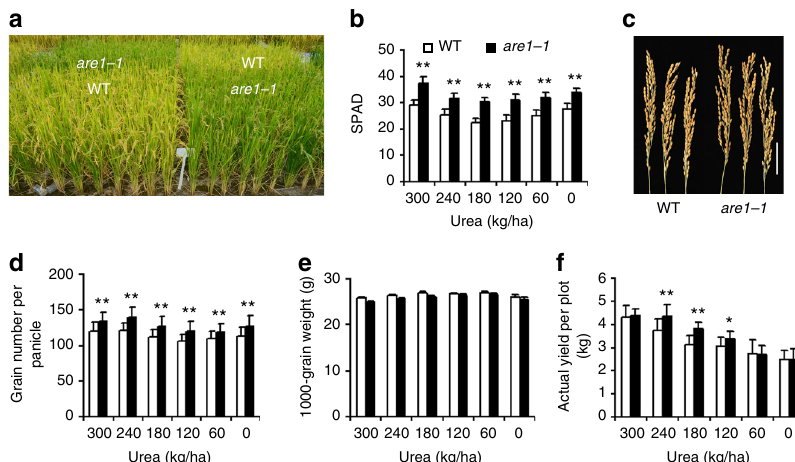
Fig. 4 Enhanced grain yield by are1 . a Grain- fi lling stage wild-type (WT; the japonica Nipponbare variety) and are1-1 plants grown under 180 kg/ha urea. See Supplementary Fig. 5a for plants grown under other nitrogen supply conditions. b Analysis of soil-plant analysis development (SPAD) in fl ag leaves of WT and are1-1 plants shown in ( a ). Data presented are mean values of 5 biological replicates with s.d. c Panicles of WT and are1-1 plants. Scale bar, 5 cm. d – f Analysis of grain number per panicle, 1000-grain weight, and grain yield per plot of WT and are1-1 plants grown under various urea concentrations as indicated ( n = 40 in ( d , e ), and n = 12 in ( f )). Error bars in ( b , d – f ) indicate s.d. *, ** P < 0.05 and P < 0.01 (Student ’ s t -test),